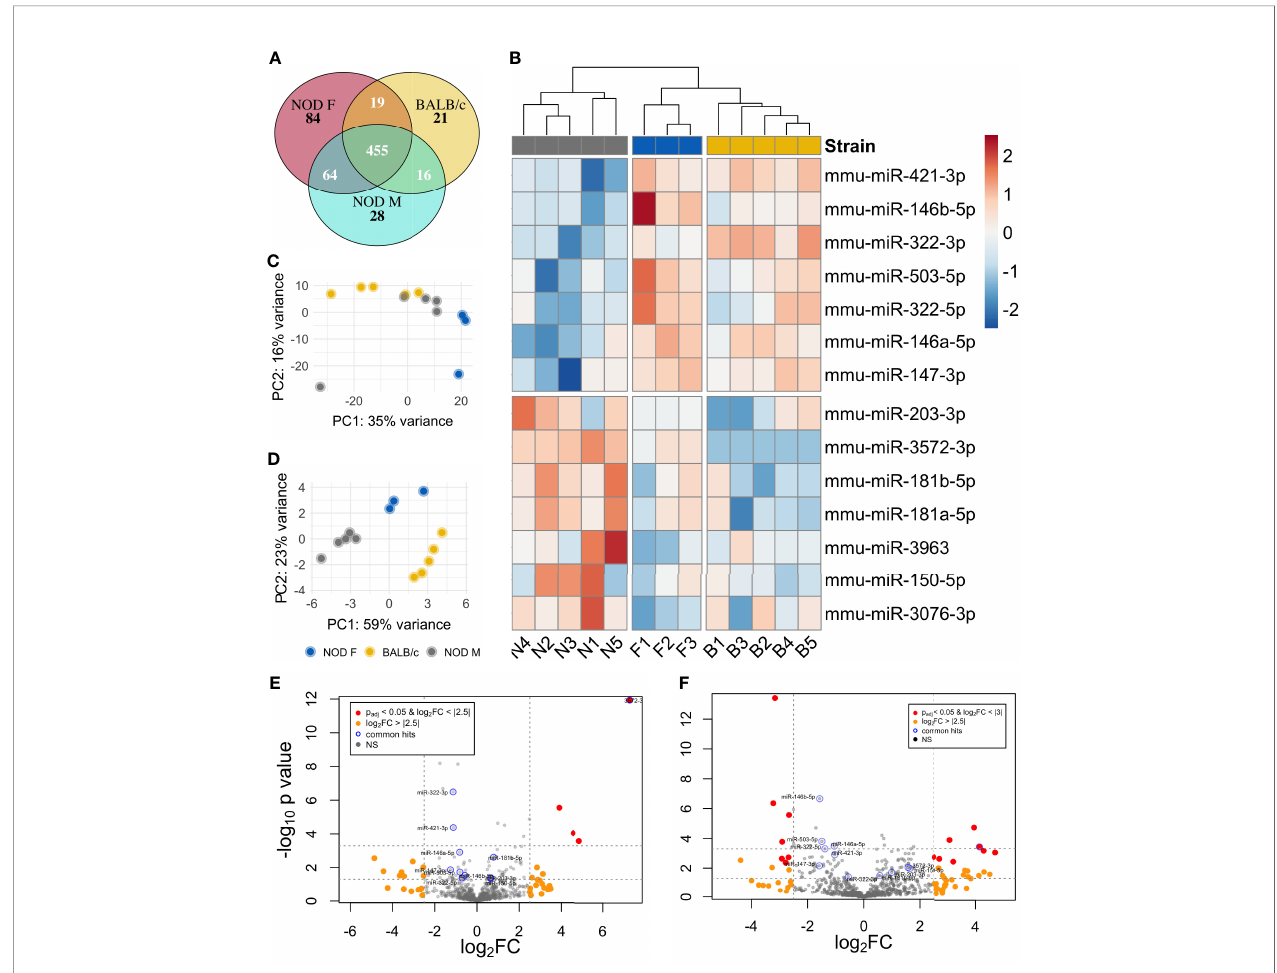
FIGURE 3 | Differential miRNA expression analysis of NOD mouse tears. (A) Venn diagram showing the overlap of miRNA in the three strains. miRNA that had normalized read counts > 0 in at least 4 out of 5 samples of NOD and BALB/c and 2 out of 3 samples for the female NOD were included for calculations. (B) Heatmap of 14 miRNA that are differentially expressed in male NOD mouse tears as compared to tears of male BALB/c and female NOD. Principal component analysis (PCA) plot of the (C) complete miRNA data and (D) top miRNA hits, characterizes the trends exhibited by the expression pro fi les of the 3 strains. Each dot represents a sample, and each color represents the type of the sample. Volcano plot of differentially expressed miRNA in NOD mouse tears as compared to (E) that of male BALB/c and (F) female